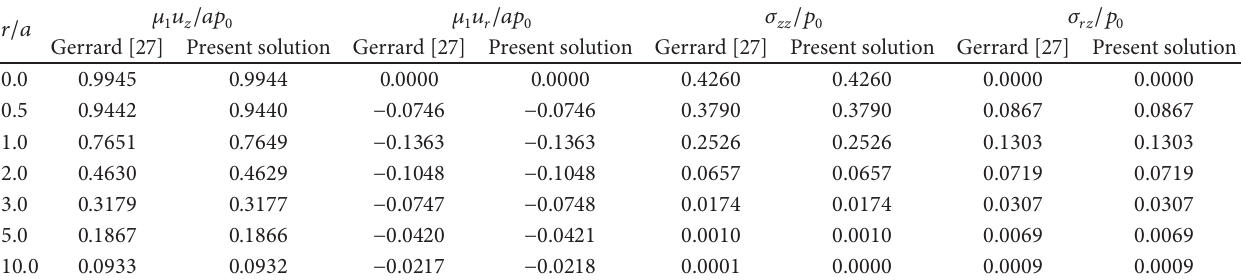
Table 1: Comparison of normalized surface displacements and stresses at the interface of a layered elastic half space under uniformly distributed normal traction for 𝜇 1 /𝜇 2 = 5 and ℎ/𝑎 = 1 .